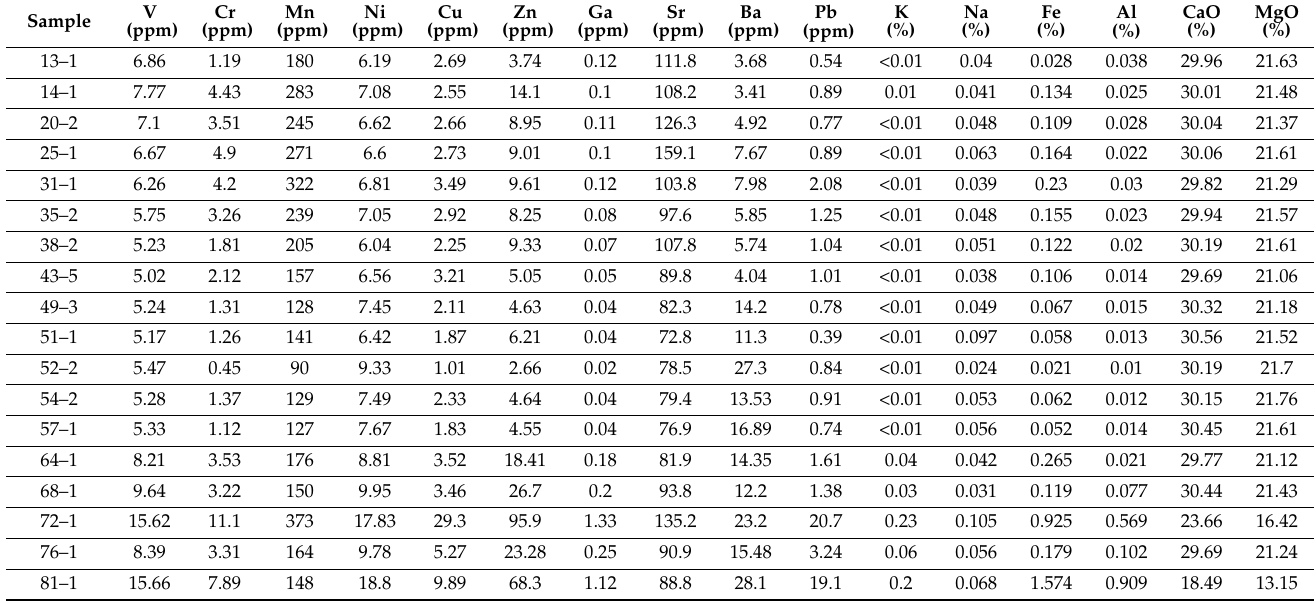
Table 2. Trace elements content of dolomite in Xiaoerblak